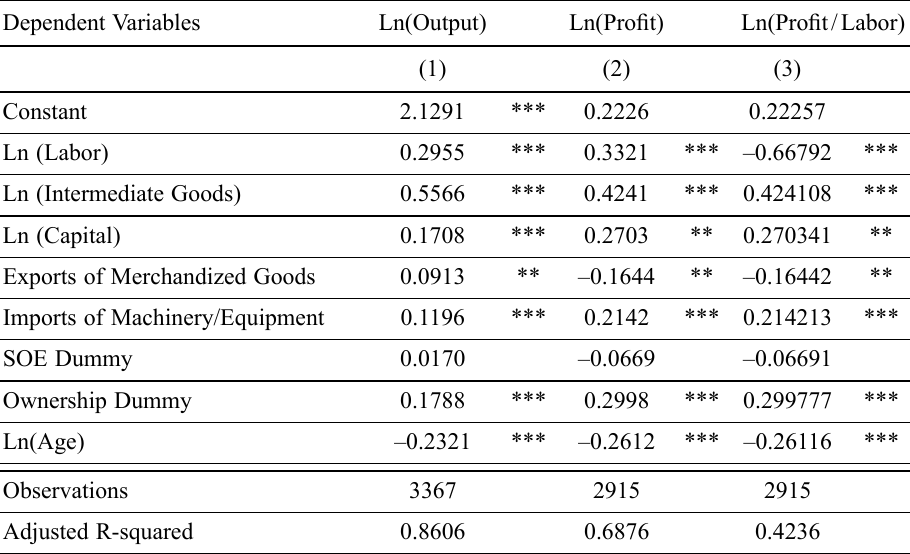
Table 2. Regressions on the relationship between firm performance and